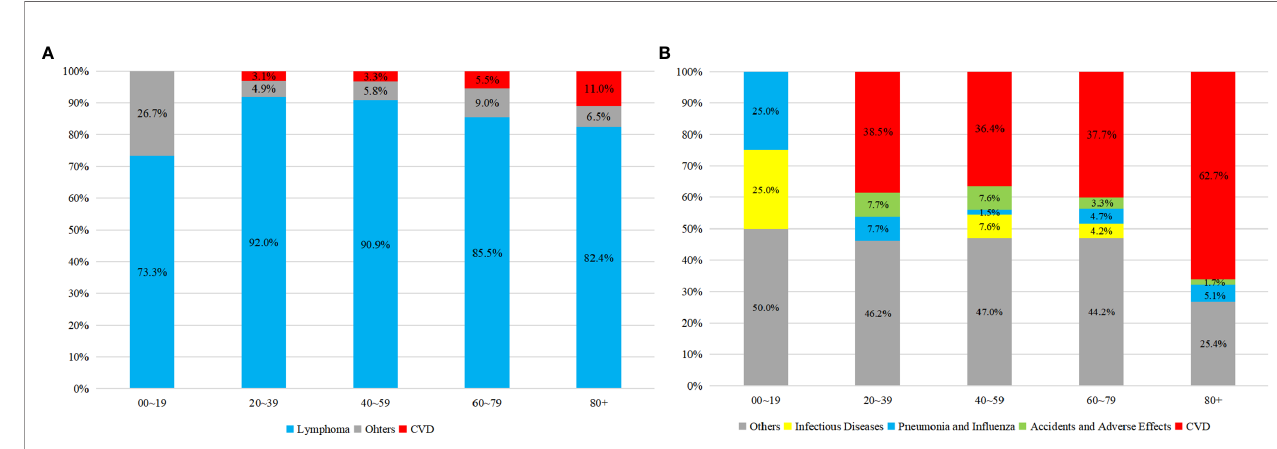
FIGURE 3 | Proportion of causes of death in PCNSLs by different age subgroup. (A) all causes of death, (B) non-cancer death.